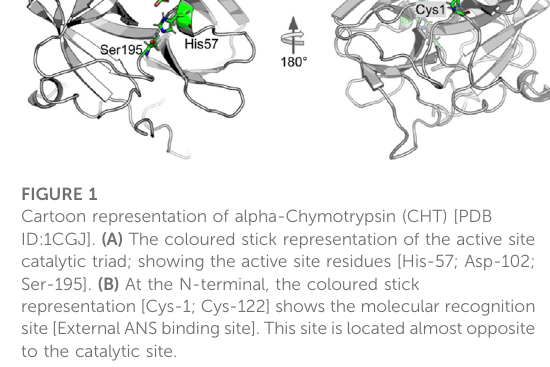
selection of the appropriate protein data bank (PDB) structure of CHT was made according to Chakraborty et al. (Chakraborty et al., 2020). Solvent accessible surface area (SASA) of CHT (PDB ID: 1CGJ) is computed using the PyMOL software (Educational